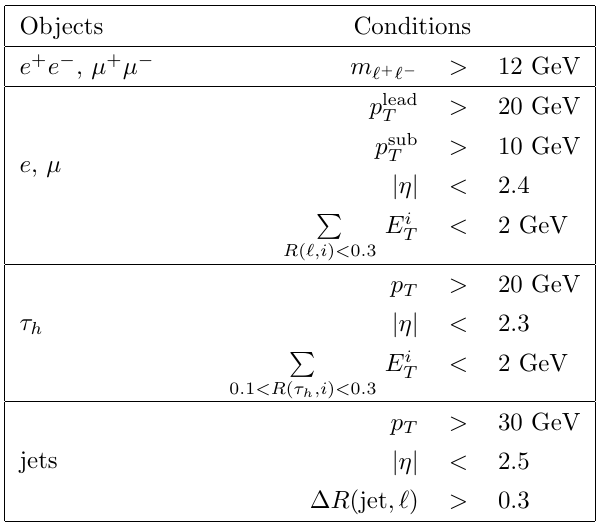
Table 3 . Summary of the cuts implemented in our simulation [53]. Jets are reconstructed using the anti-kT algorithm [86] with a distance parameter R = 0 : 5, and ‘ in the last row stands for the isolated electron, muon, or (cid:28) h candidates.